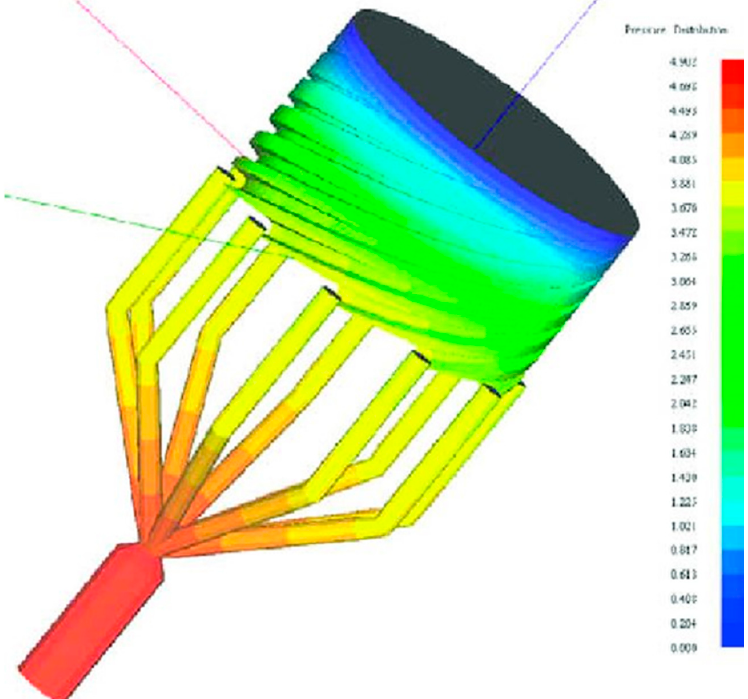
Figure 2. Pressure distribution predicted by SPIRALCAD ADVANCE in modelling of polymer film blowing adapted from Vlachopoulus and Sidiropoulos [52] with permission from Elsevier, 2020.